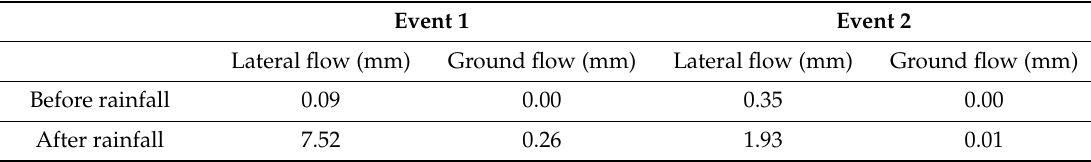
Table 3. Lateral and ground water flow in Event 1 and Event 2.